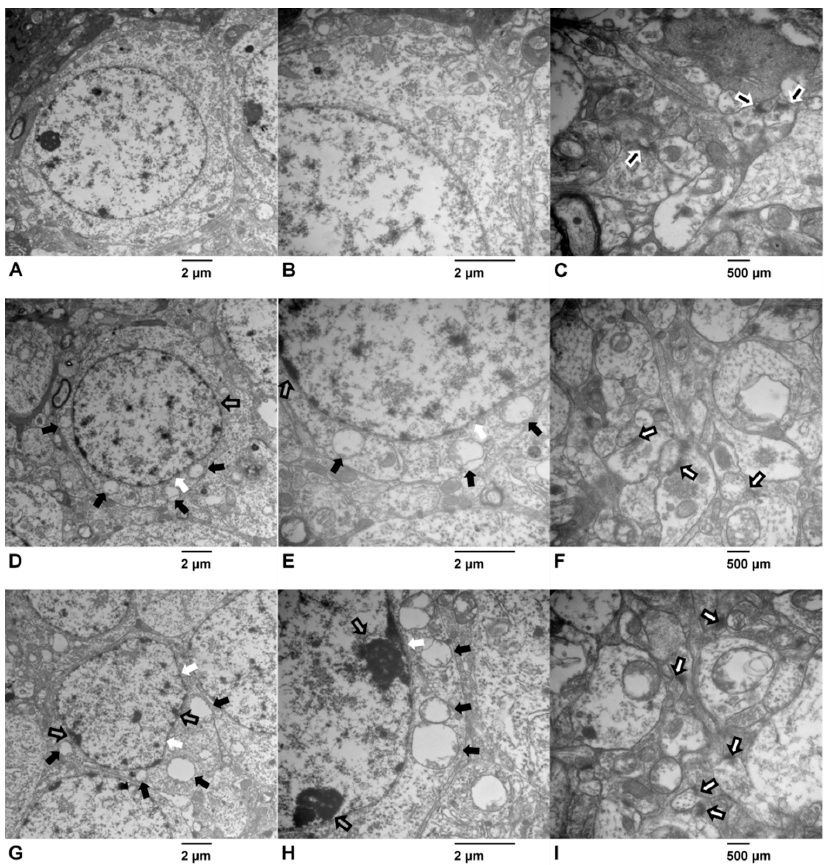
Figure 2. Effects of atrazine (ATR) on the ultrastructural features of the hippocampal neurons via transmission electron microscopy: control group: ( A ) 10,000×, ( B ) 20,000×; low-dose group: ( D ) 10,000×, ( E ) 20,000×; high-dose group: ( G ) 10,000×, ( H ) 20,000×. Effects of ATR exposure on the ultrastructural features of the hippocampal synapses via transmission electron microscopy: control group: ( C ) 30,000×; low-dose group: ( F ) 30,000×; high-dose group: ( I ) 30,000×. Six rats per group. Obvious changes are marked with different arrows, white arrows: fuzzy karyolemma; black arrows: swollen mitochondria; gray arrows with a black edge: concentrated chromatin granules; black arrows with a white edge: normal synaptic clefts and white arrows with a black edge: unclear synaptic clefts.